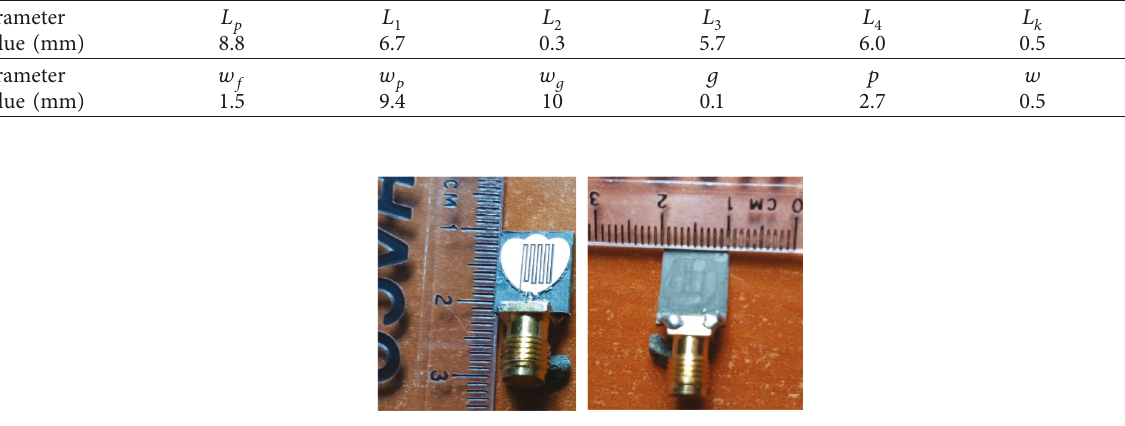
Figure 2: The fabricated MSB antenna.